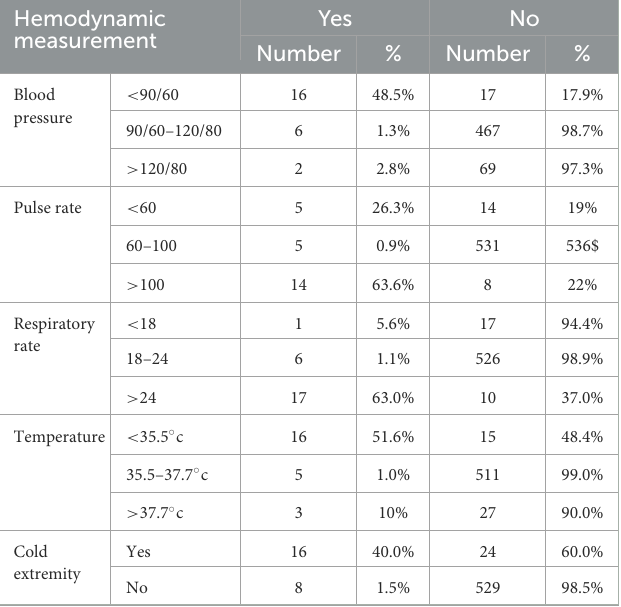
TABLE 2 Distribution of delivering women by their past obstetric history in the district areas health centers of Gedeo Zone, Southern Ethiopia, 2021 ( N = 577).